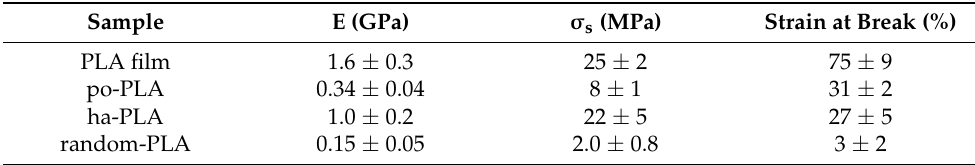
Table 5. Young’s modulus (E), tensile strength ( σ s ) and strain at break of PLA film, po-PLA and ha-PLA electrospun